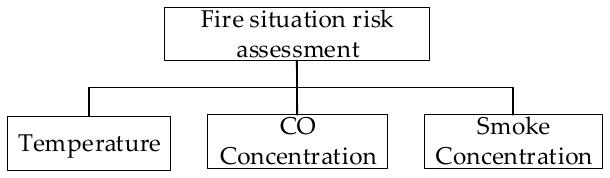
Figure 8. Comprehensive evaluation system.